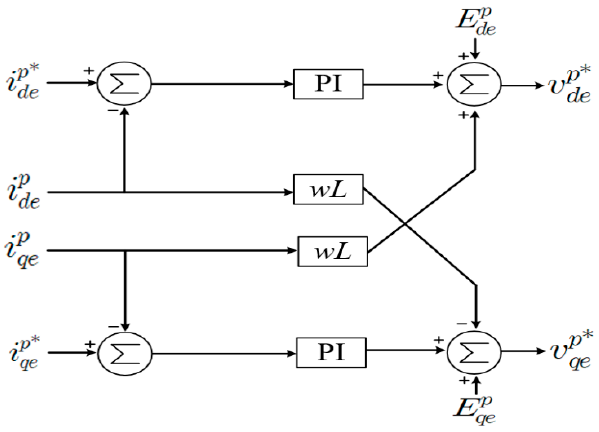
Figure 4. Control diagram of the positive sequence current (PSC).